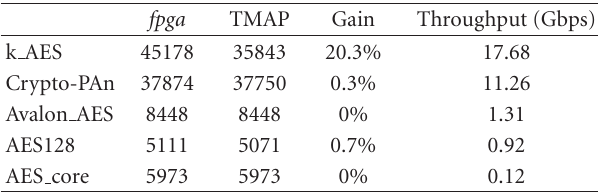
Table 1: The resource usage, in 4 LUTs, of the di ff erent AES